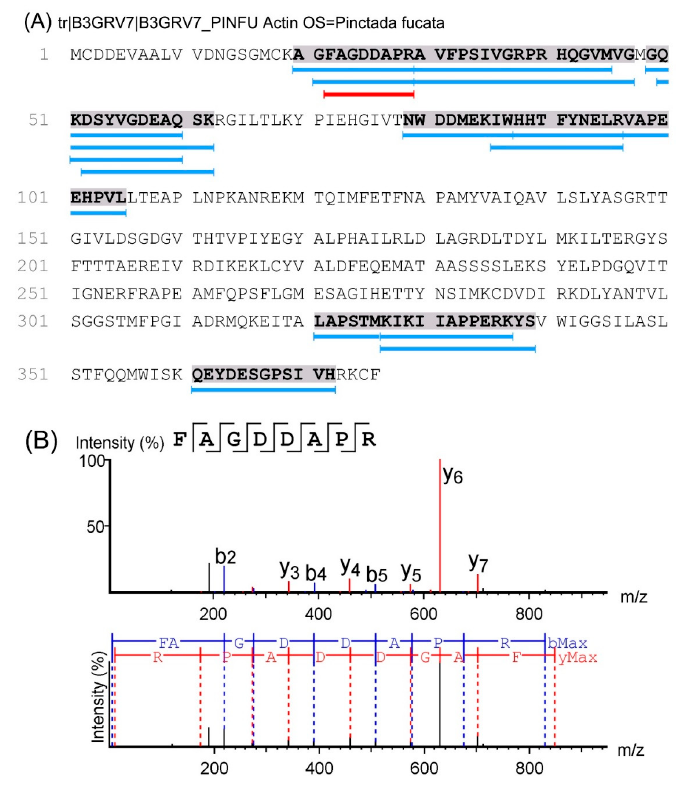
Figure 3. ( A ) Sequence of actin and the distribution of identified peptides. ( B ) Identification of peptide FAGDDAPR (F22–R29).